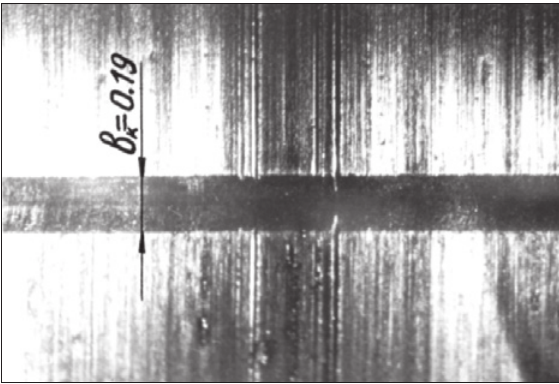
Fig. 14. Traces of penetration of micro asperity projections into the edges of micro grooves, which formed as a result of a micro seizure (h k = 3 µm, r k = 1.5